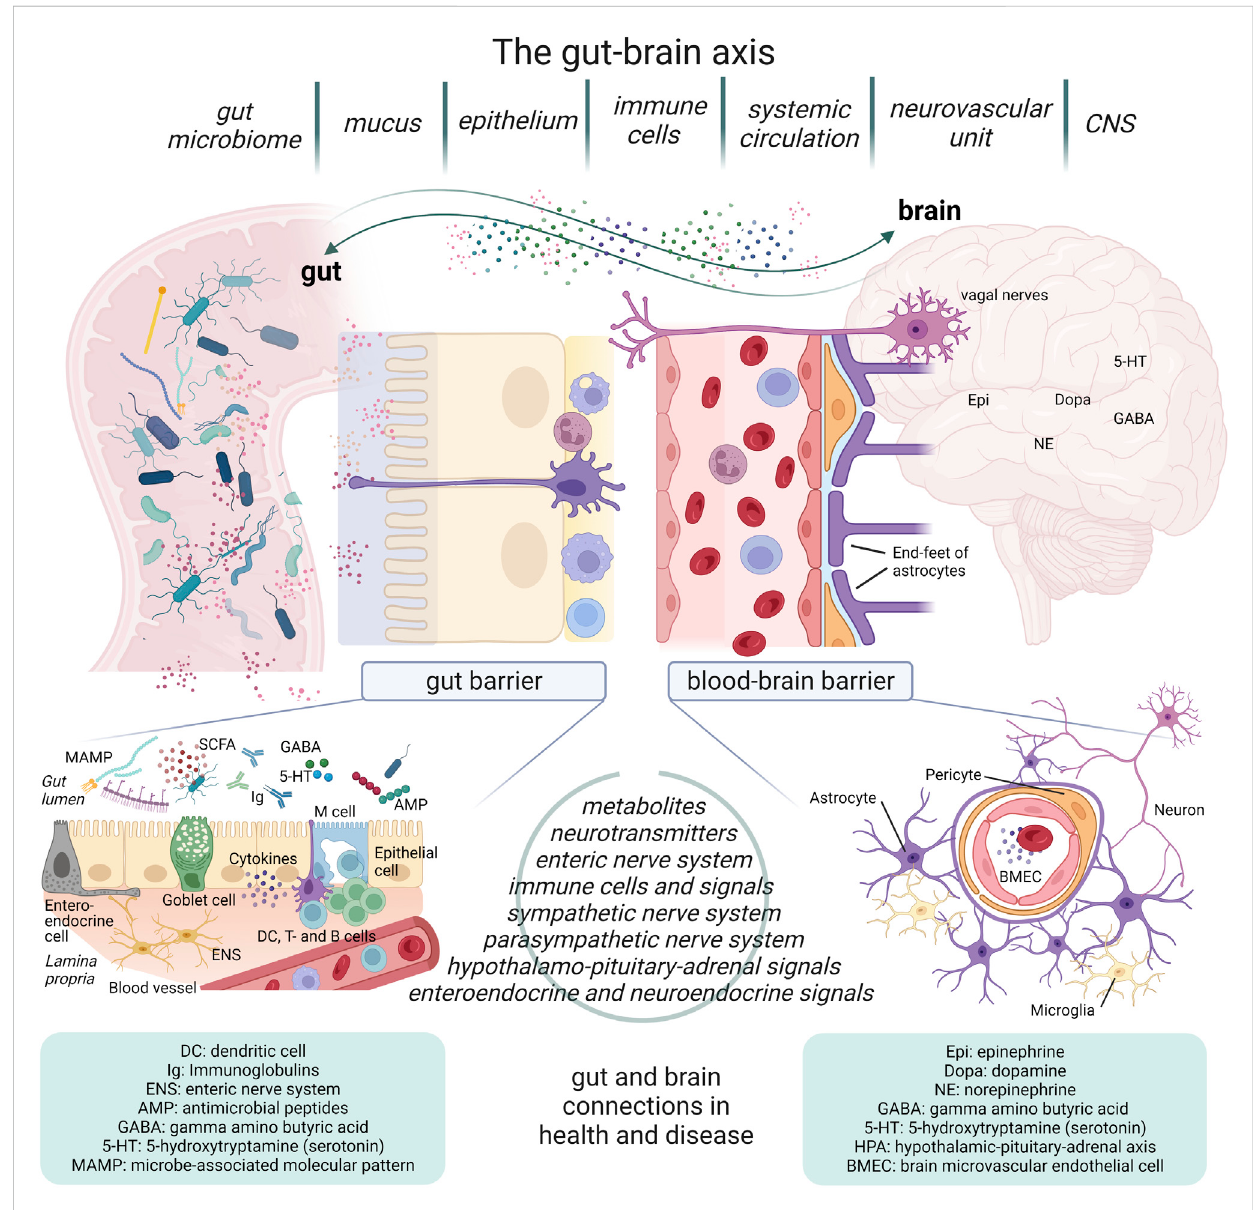
FIGURE 1 Overviewofthegut-brainaxis.Thegut-brainaxis(GBA)constitutesmultipleconnectionsbetweenthegutandthebrainseparatedbythegutbarrier andtheblood-brainbarrier(BBB).Thegutmicrobiomecontributessigni fi cantlywithawiderangeofmolecules,includingmicrobe-associatedmolecular patterns (MAMPs), immune signaling, metabolites, and neurotransmitters. The enteric nerve system is considered a “ second brain ” , and it is part of the conduction system leading signals on to the CNS, along with vagal and endocrine pathways from specialized cells of the gut mucosa. The systemic blood system is separated from the brain ’ s vascular system by the BBB, consisting of the neurovascular unit of brain microvascular endothelial cells, pericytes, and astrocytes. Together these two barriers outline the signi fi cant functional and physiological diversity of the GBA, relevant in health and disease. (The fi gure was created with